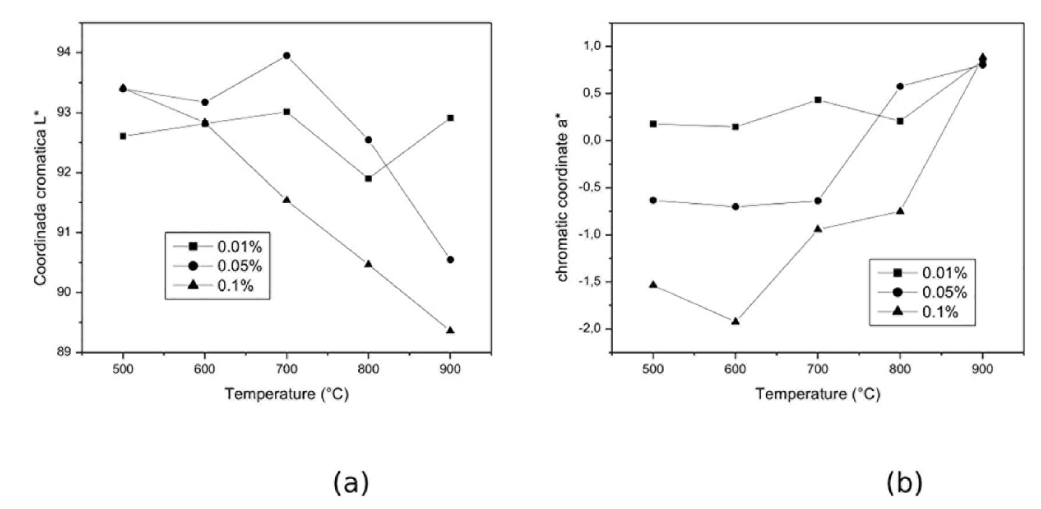
Figure 4: Chromatic coordinates of the of the Li